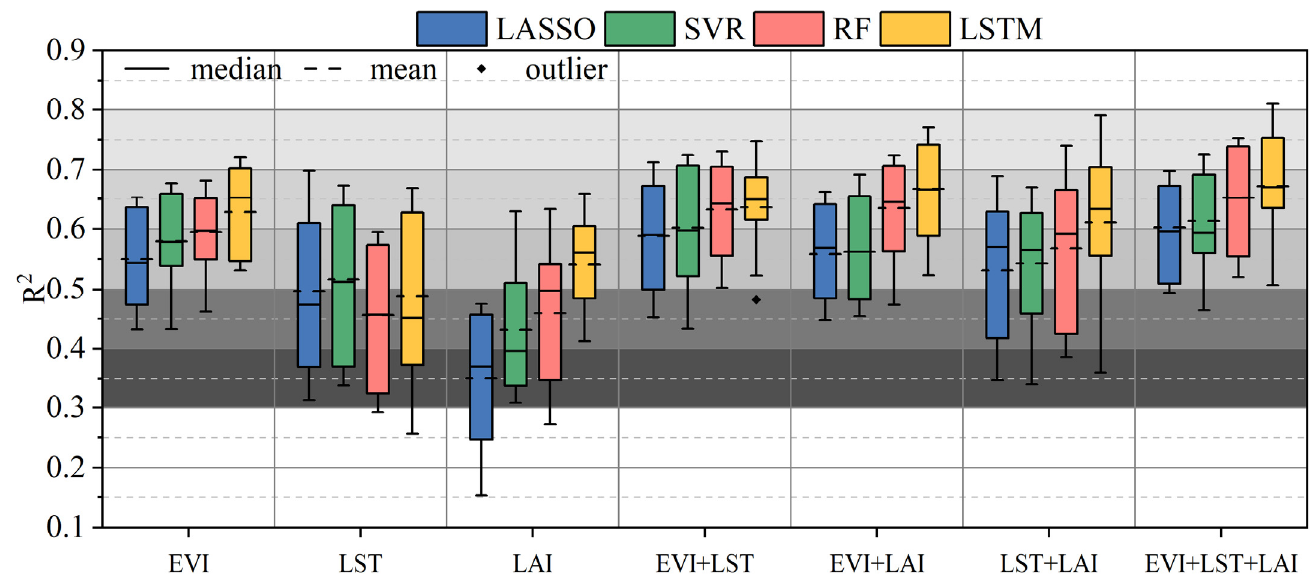
Figure 4. Model performance (predicted R 2 ) for the four methods using various combinations of satellite-derived index inputs in the whole GS. Different colors represent different methods (blue green, red and yellow for LASSO, SVR, RF and LSTM, respectively). R 2 values in Box plots were derived from LOYO-CV. Gray represents the R 2 value; the lighter the gray, the higher the R 2 .